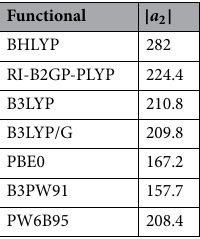
Figure 2. The highest occupied molecular orbital of [Li + -O2 (http:// www. ibovi ew.